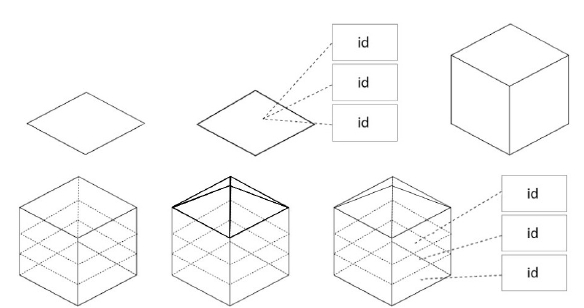
Figure 1 . Schema on example of data relation from public real estate to the building units and to the floors